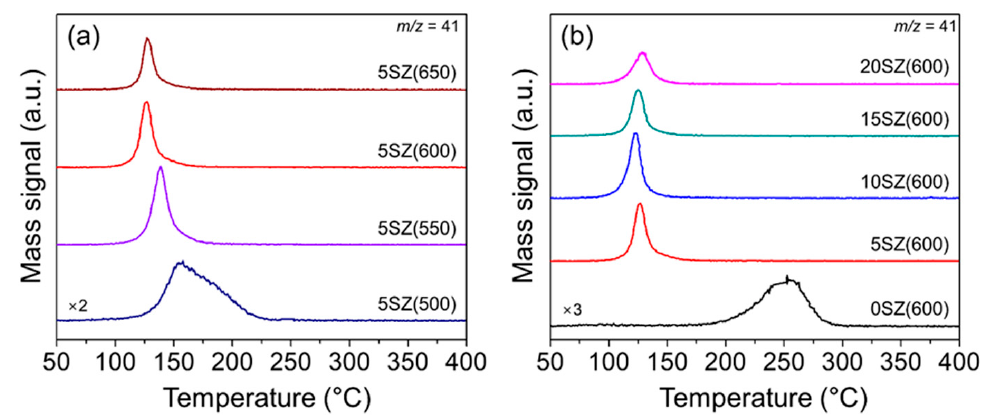
Figure 6. Evolution of · C 3 H 5 ( m/z = 41) in mass spectra as a function of desorption temperature during IPA-TPD analysis over ( a ) 5SZ( y ) and ( b ) x SZ(600) catalysts.